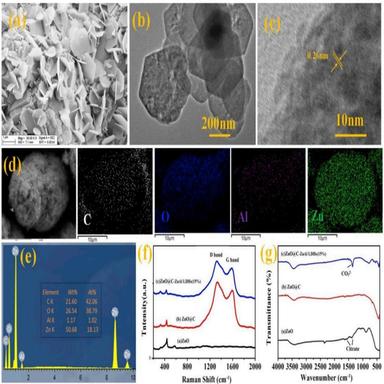
(a) FE-SEM images and (b, c) TEM images of the ZnO@C-ZnAl LDHs(15%) at different magnifications; (d, e) EDS result of the ZnO@C-ZnAl LDHs(15%) sample with FESEM-EDS analysis showing the elemental mapping of C, O, Al, and Zn; (f) Raman spectra and (g) the Fourier-transform infrared (FT-IR) spectrum of the three ZnO microspheres.